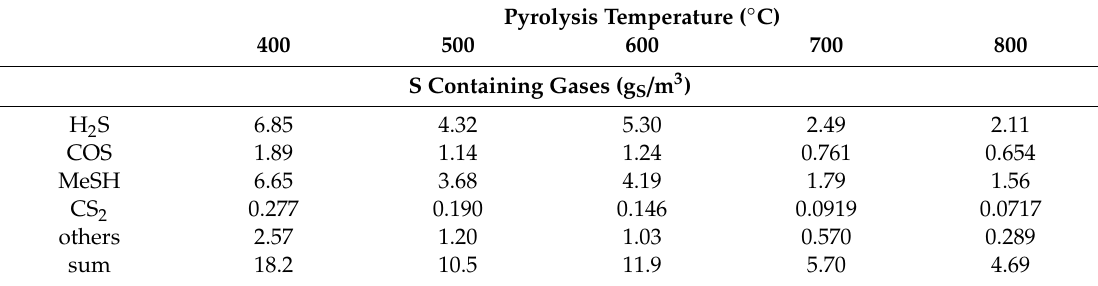
Table 3. Sulfur-containing compounds of pyrolysis gas depending on pyrolysis temperature, Adapted from Moško et al.